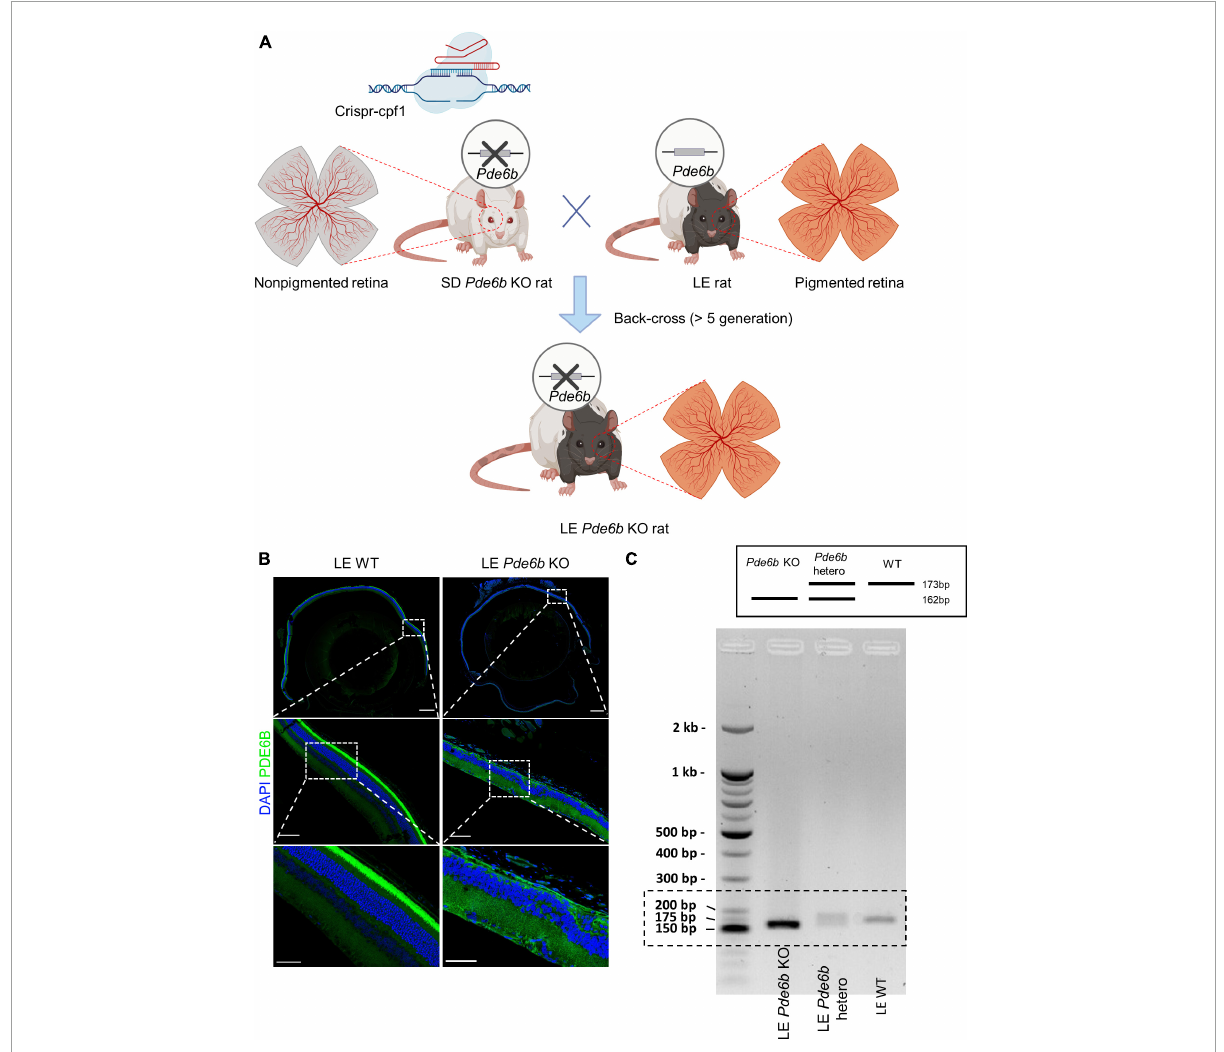
FIGURE1 Generation of pigmented Pde6b -knockout Long–Evans rats. (A) Schematic illustration depicting the process of generating the Long–Evans Pde6b -knockout rat (LE Pde6b KO). A CRISPR-Cpf1 engineered Sprague–Dawley (SD) rat with a deletion of the Pde6b gene is back-crossed over at least five generations with LE rats. Schematic created with BioRender. (B) Immunofluorescent images of the cross-sectioned retina of 17-weeks old rat. Insets indicate the location of the magnified images. Scale bars, 500 µ m (top), 100 µ m (middle), 50 µ m (bottom). (C) Genotyping result of the WT, Pde6b -heterozygote, and Pde6b -knockout rat of the Long-Evans strain for the detection of the mutant allele. WT,